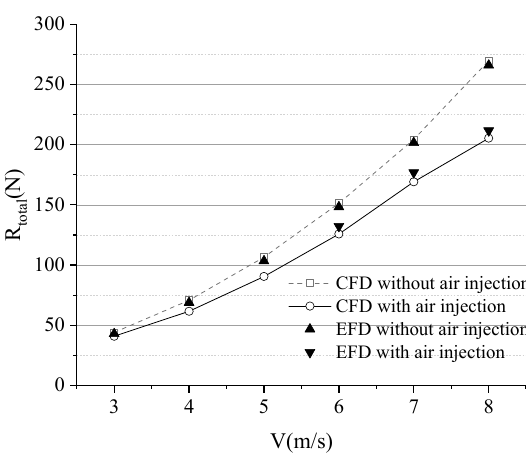
Figure 5. The total resistance R total .